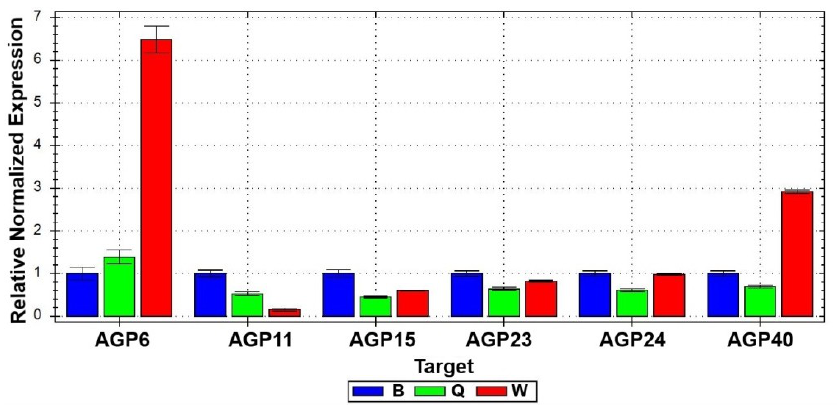
Figure 1. Real-time PCR results of the expression levels of six AGP genes in pollen tubes growing in three different growth media, B, Q and